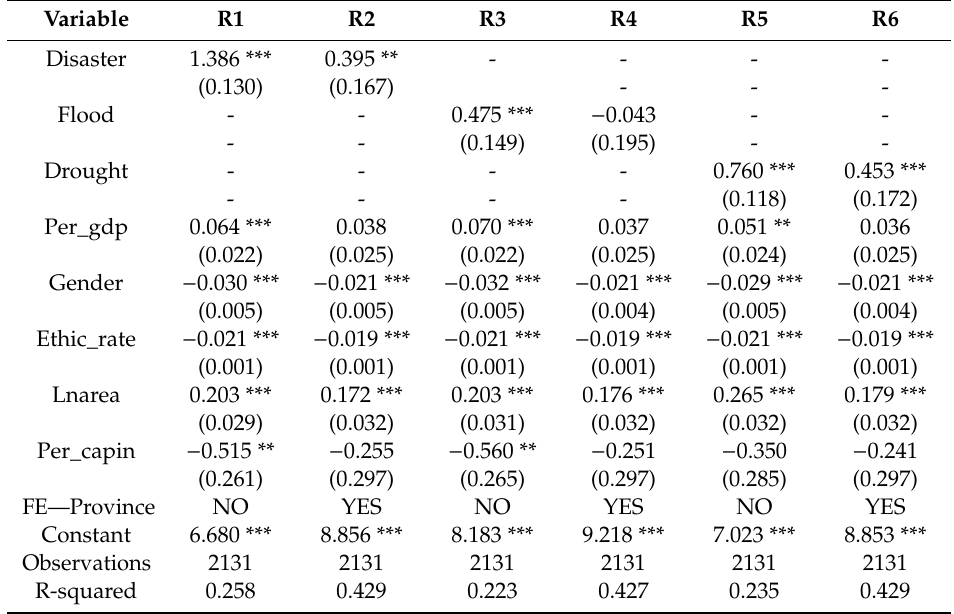
Table 4. Impactof20years(1980–2000)ofdisasterfrequencyoncontemporaryhumancapital, OLSestimates.